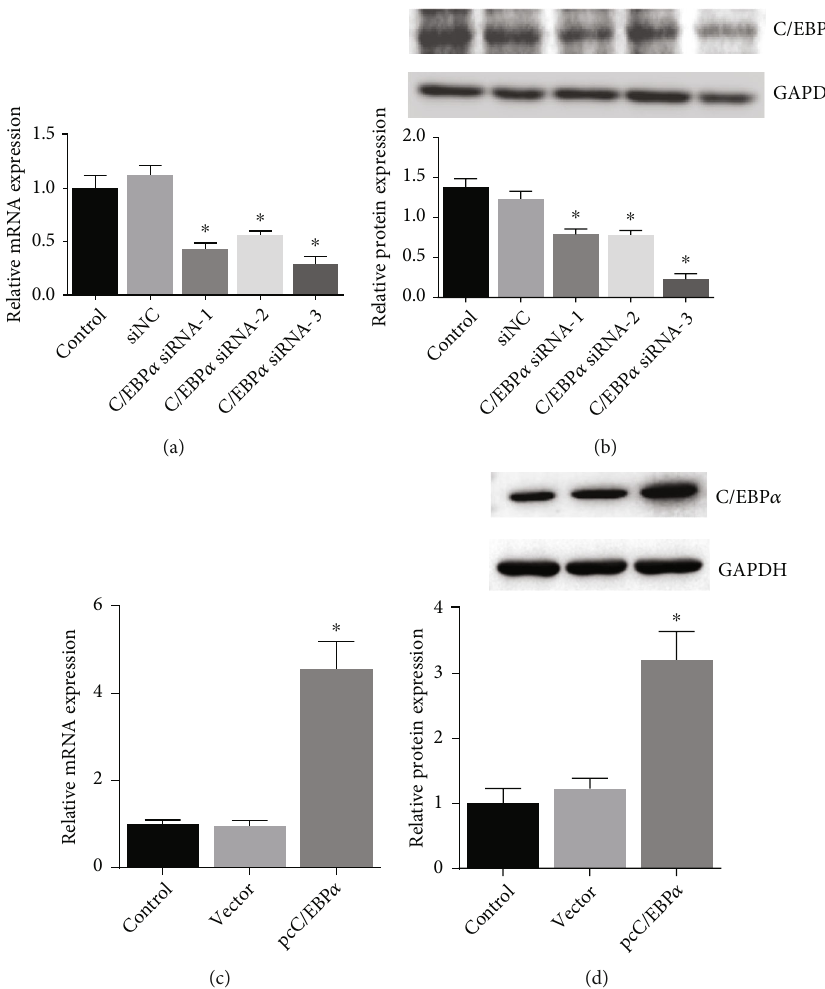
Figure 3: C/EBP α knockdown and overexpression in aortic VSMCs. C/EBP α was knocked down using three independent siRNAs in aortic VSMCs, and knockdown was con fi rmed at both mRNA level by RT-qPCR (a) and protein level by Western blot (b). To overexpress C/EBP α in aortic VSMCs, C/EBP α cloned in pcDNA3.1 (pcC/EBP α ) was transfected and con fi rmed at both mRNA level by RT-qPCR (c) and protein level by Western blot (d). Experiments done in triplicate. ∗ P < 0 : 05 vs. (Figure 8). Compared to pcC/EBP α +siNC group, PIK3C2A